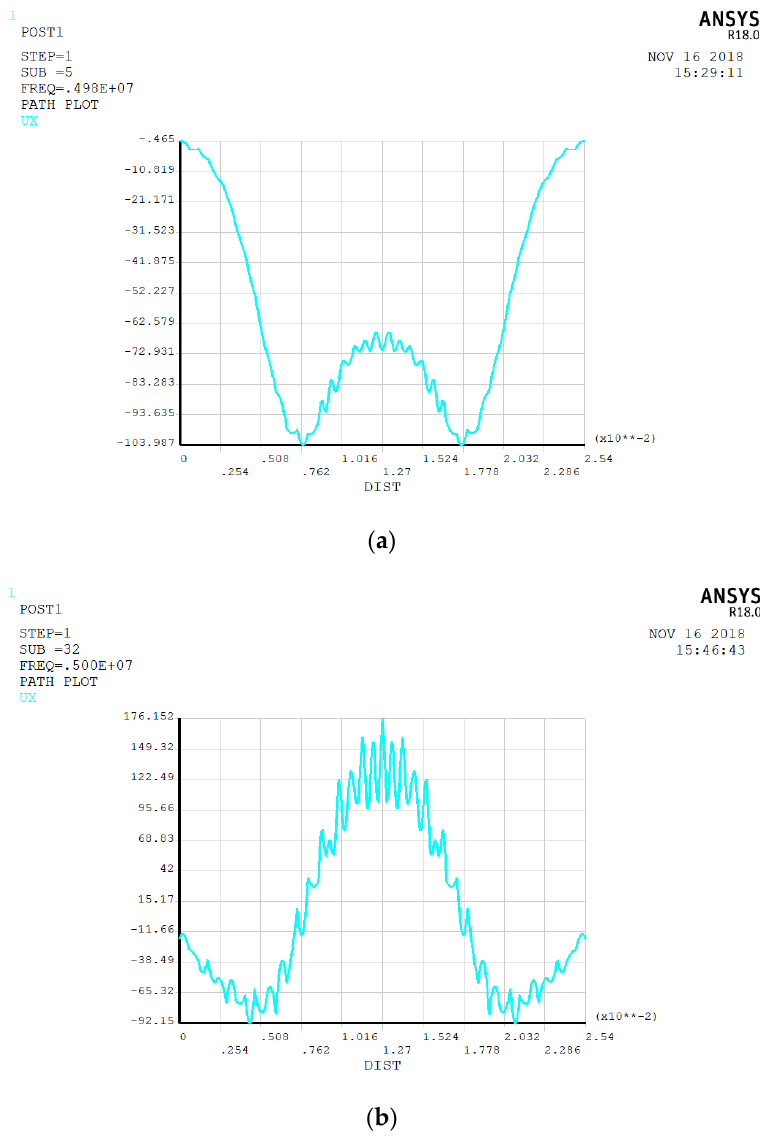
Figure 5. ( a ) The curve of vibration displacement at the outer diameter of 8 mm; ( b ) the curve of vibration displacement at the outer diameter of 10 mm.